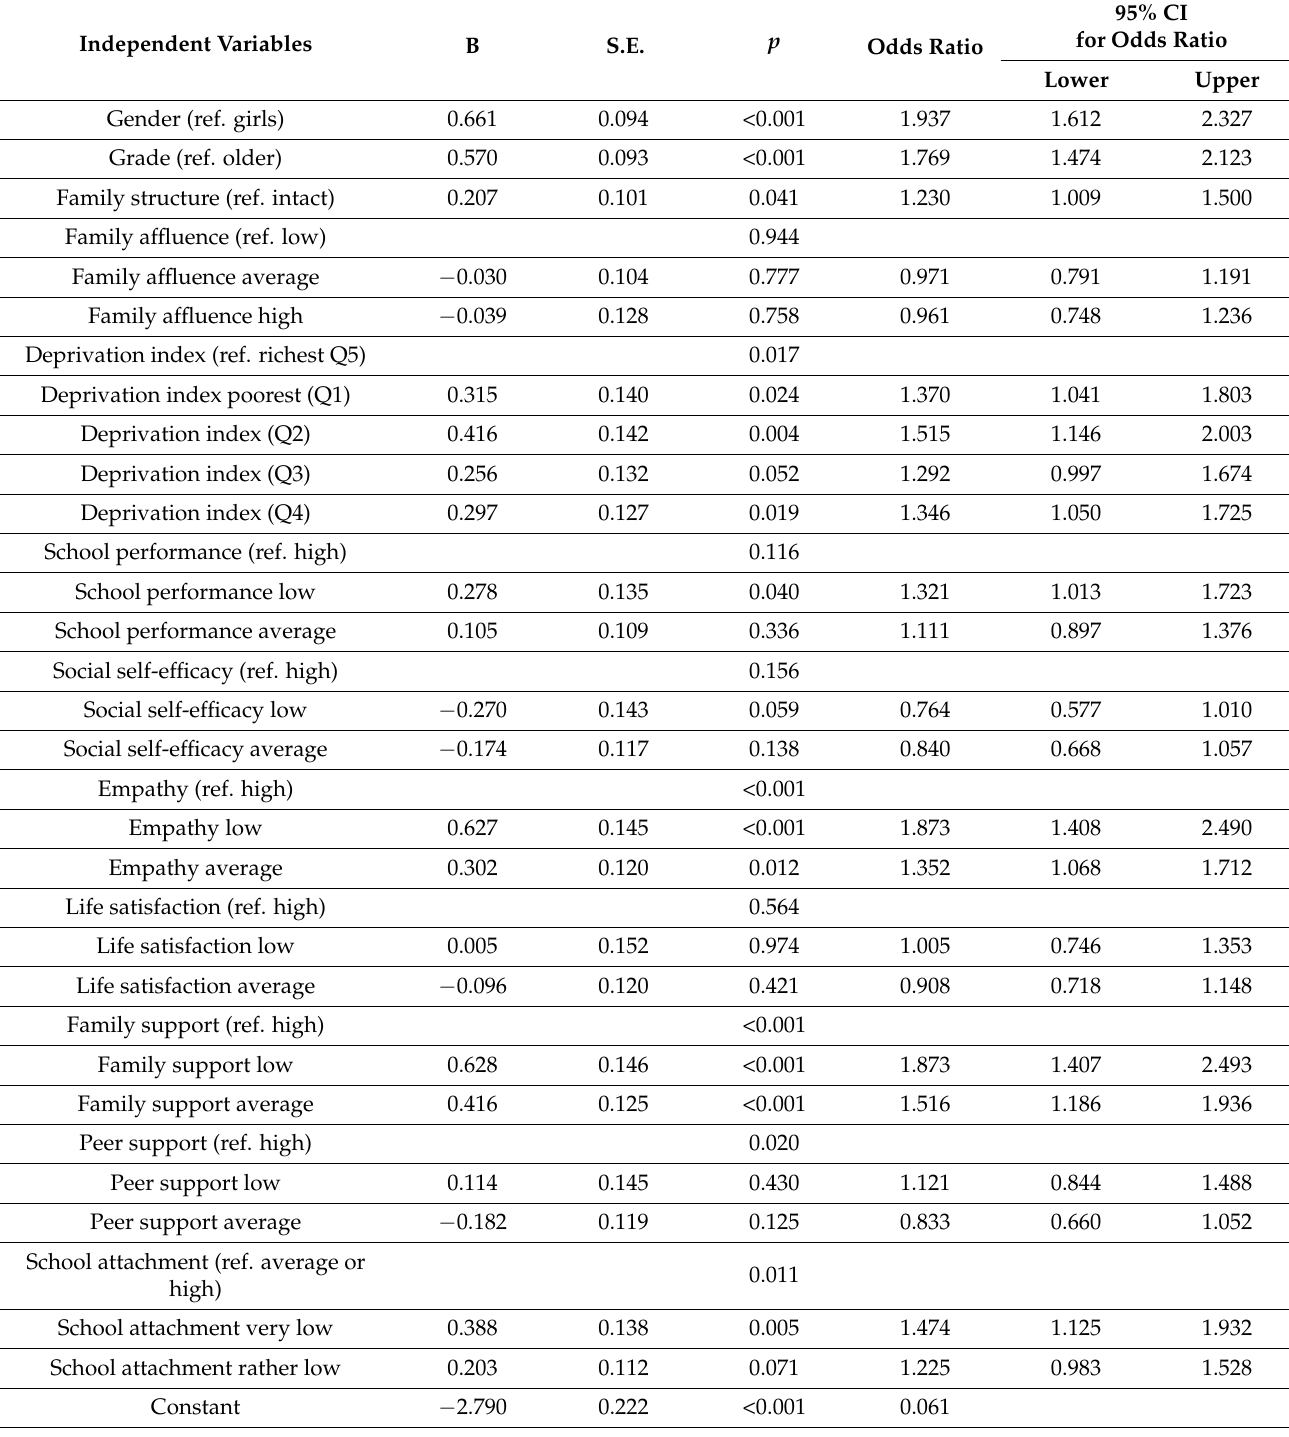
Table 5. Logistic regression predicting likelihood of bullying